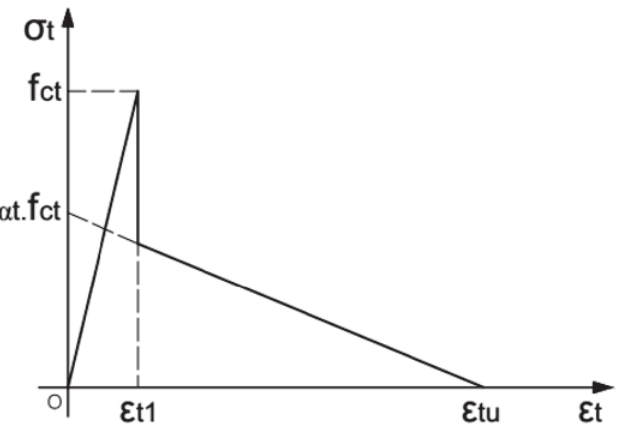
Figure 3.5 Stress-atrain relation for concrete in uniaxial tension (adopted from Martinelli,